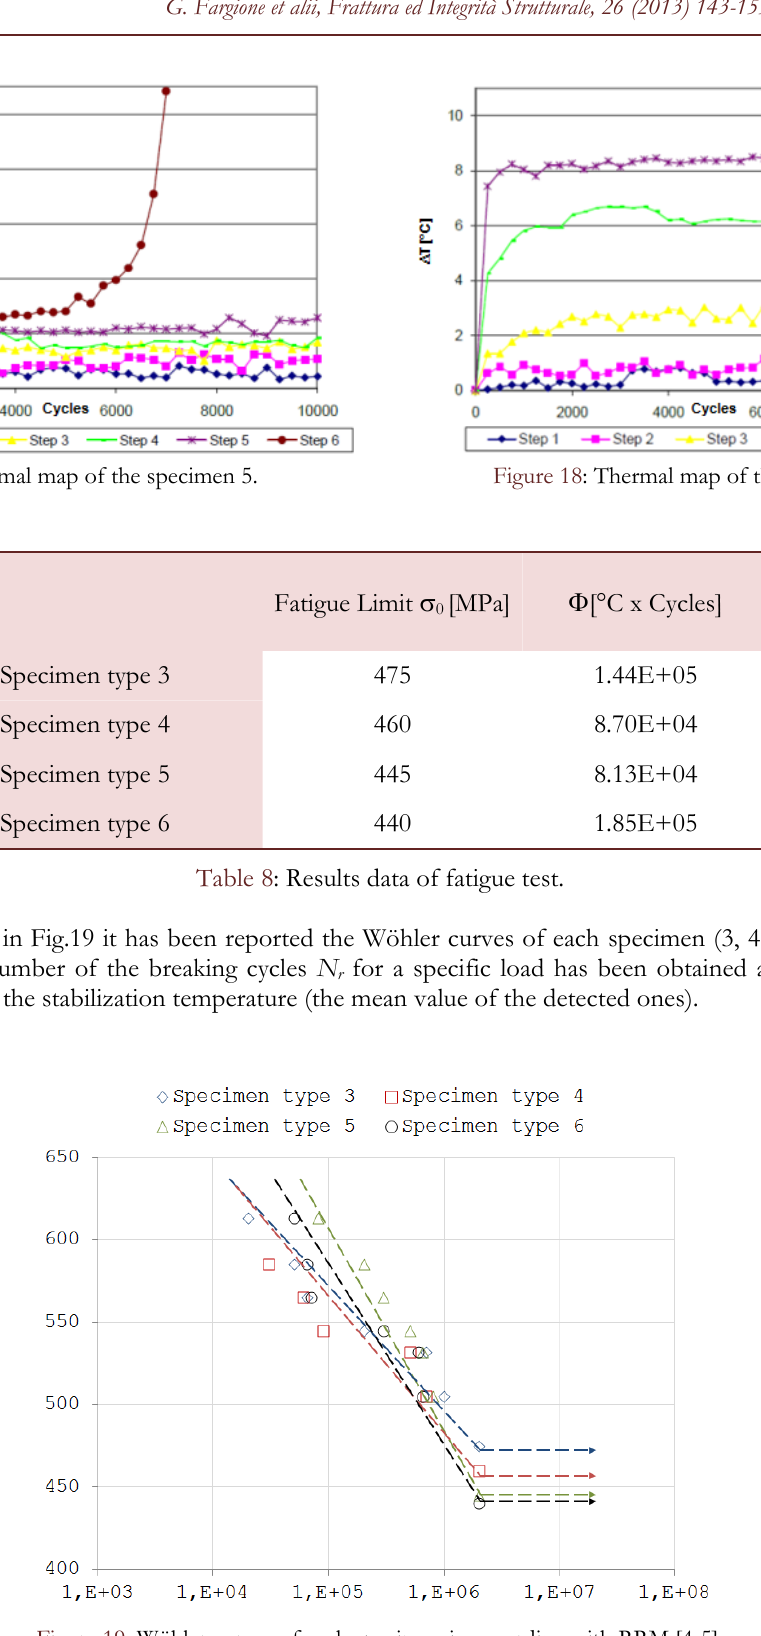
Figure 19: Wöhler curves of each specimen in according with RRM